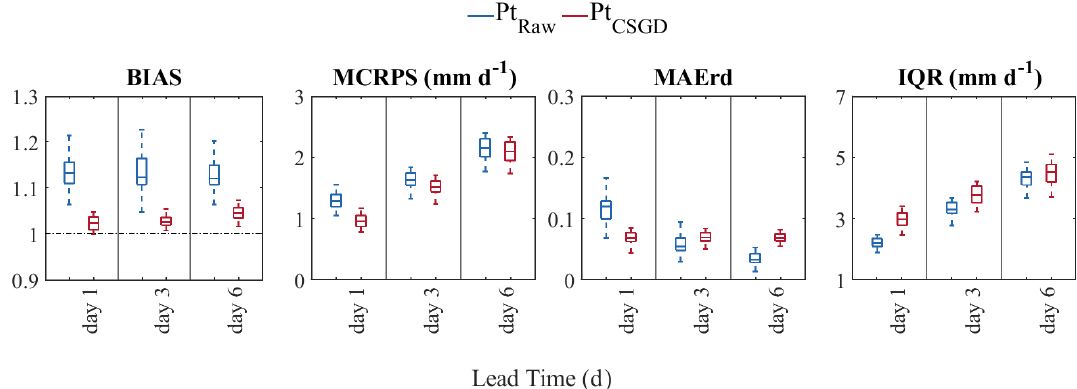
Figure 4. BIAS, MCRPS, MAE rd , and IQR of raw (blue) and post-processed (red) daily catchment-based precipitation forecasts for lead times of 1, 3, and 6d over the evaluation period (2011–2016). Box plots represent the distribution of the scores over 30 catchments.